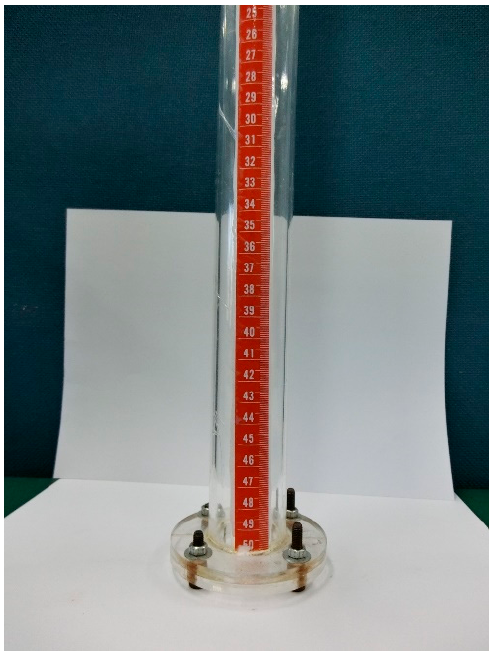
Figure 5. FBG pressure sensor unit installed at the bottom of a liquid container. When the FBG-based diaphragm sensor was placed at the bottom of liquid, the hydrostatic pressure induced a compression on the diaphragm resulting in the tangential and radial strains as shown in Equations (4) and (5), respectively. The radial strain caused an extension of the FBG sensor, leading to a Bragg wavelength shift ∆ λ B from which the pressure can be determined using Equation